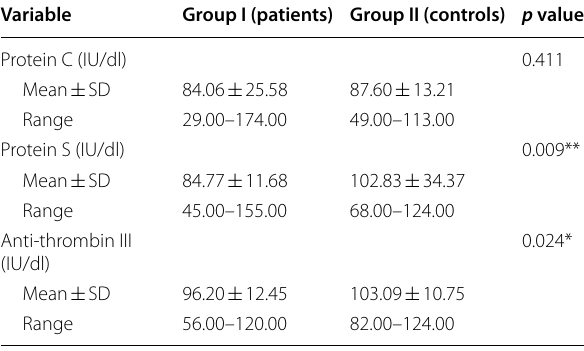
Table 2 Mean and range of serum levels of protein C, protein S, and anti-thrombin III and comparison between both groups